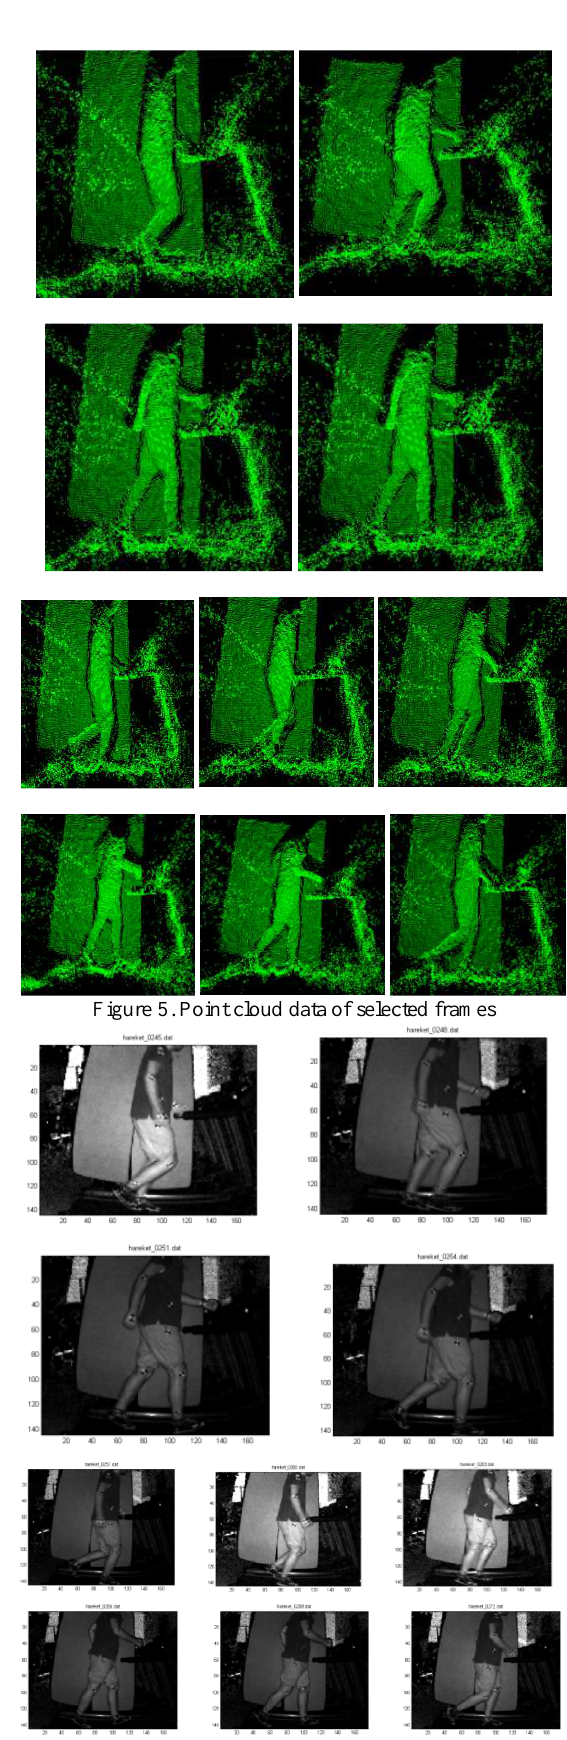
Figure 6. Intensity images of selected